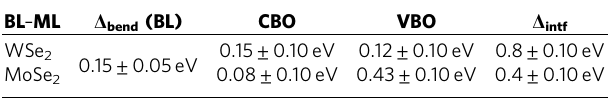
Table 1 | Band alignments in bilayer-monolayer hetero- junctions for WSe 2 and MoSe 2